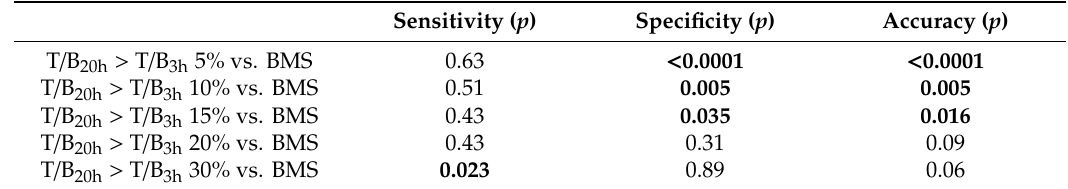
Table 5. Comparison between di ff erent thresholds of semi-quantitative analysis and BMS according to final diagnosis in terms of p